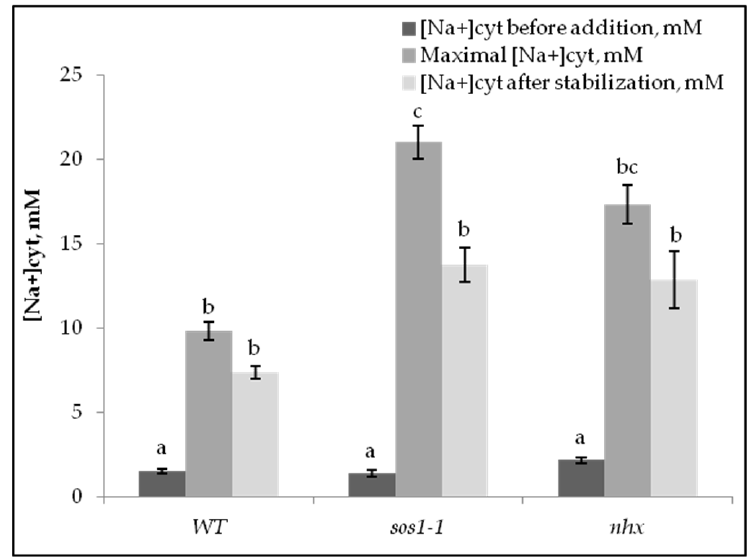
Figure 2. Changes of [Na +cyt ] in mM of mesophyll protoplasts of Arabidopsis wild type, sos1 ‐ 1, and nhx1 genotypes upon addition of 100 mM of NaCl, and after stabilization. Means ± SE.